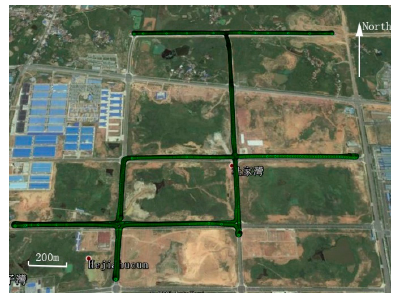
Figure 2. Vehicular trajectory of the field test.